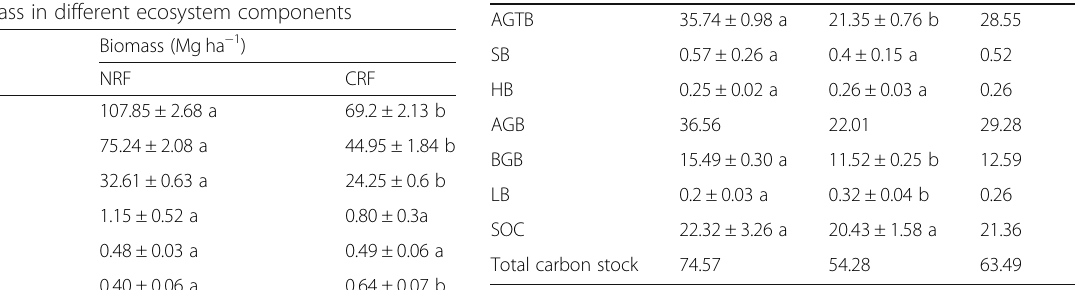
Table 4 Carbon content in different pools of forests Forest carbon